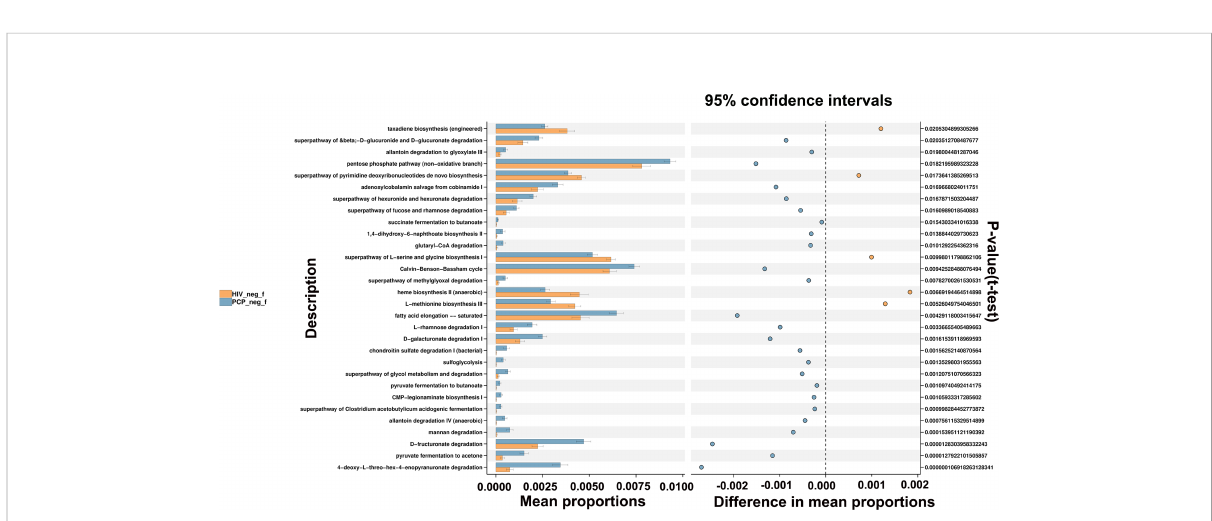
FIGURE 9 The difference in the KEGG pathways of gut microbiota between HIV+PCP- and HIV- patients. HIV_neg_f: HIV- group; PCP_neg_f: HIV+PCP-